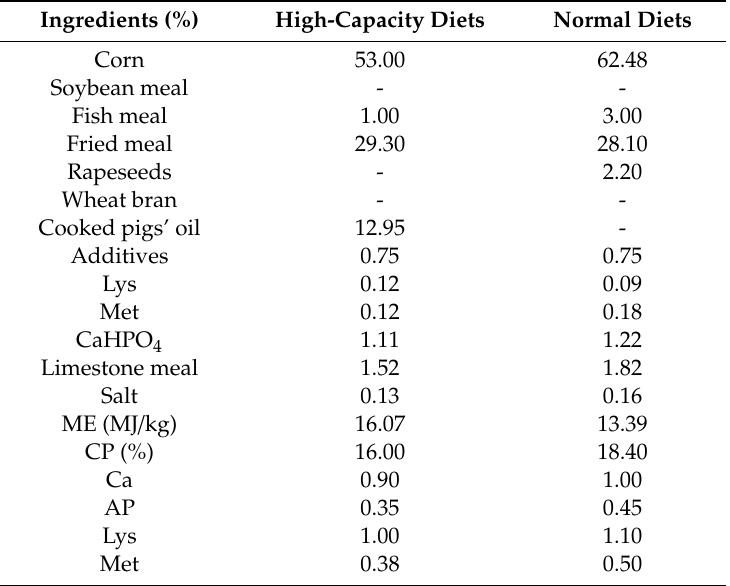
Table 1. Composition and nutrient levels of the